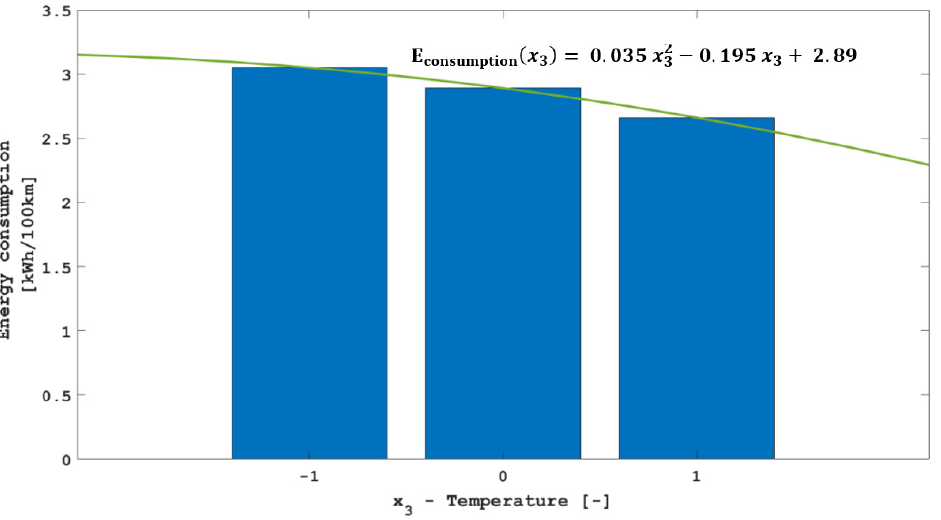
Figure 13. The average consumption values of an electric scooter depend on the outside temperature occurring during the trip.